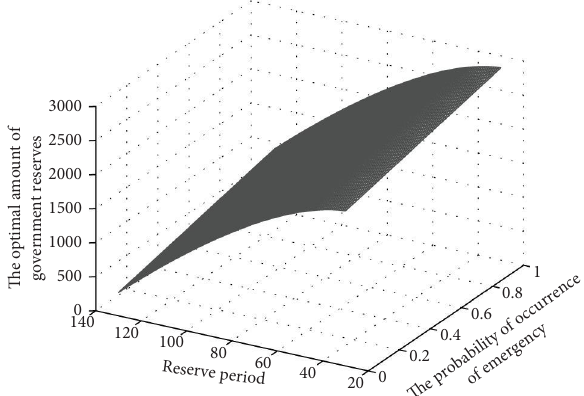
Figure 2: Te infuence of the probability of emergency occurrence and the reserve period on the optimal reserve amount of supplier 1.